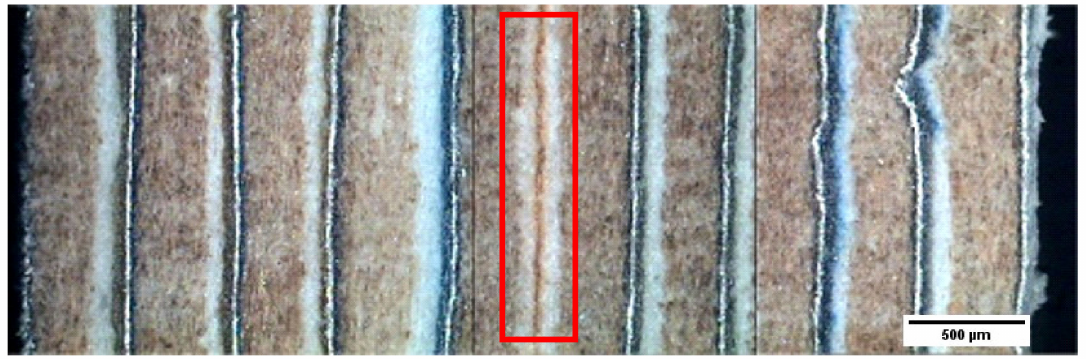
Figure 15. Micrograph of six sheets (G2). The “neutral or central” layer is marked with a rectangle.